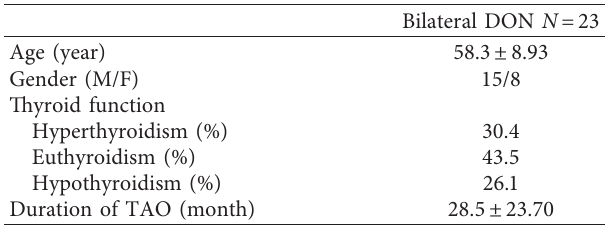
Figure 1: One case diagnosed with bilateral dysthyroid optic neuropathy (DON). (a) Eye movement testing showed limited eye movement and strabismus in both eyes. (b) Magnetic resonance imaging (MRI) showed enlargement of extraocular muscles. Table 1: Demographic characteristics of the patients with bilateral